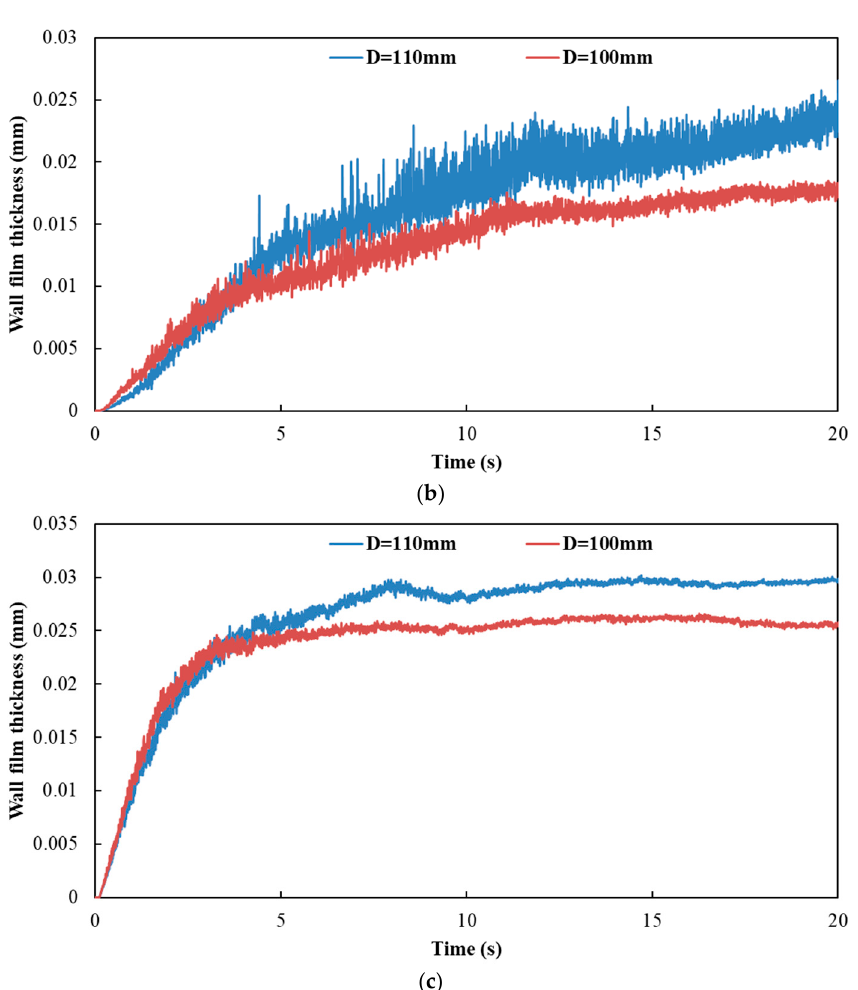
Figure 19. Influence of different exhaust pipe diameters on wall film thickness. ( a ) Case 1; ( b ) Case 2; ( c ) Case 3.